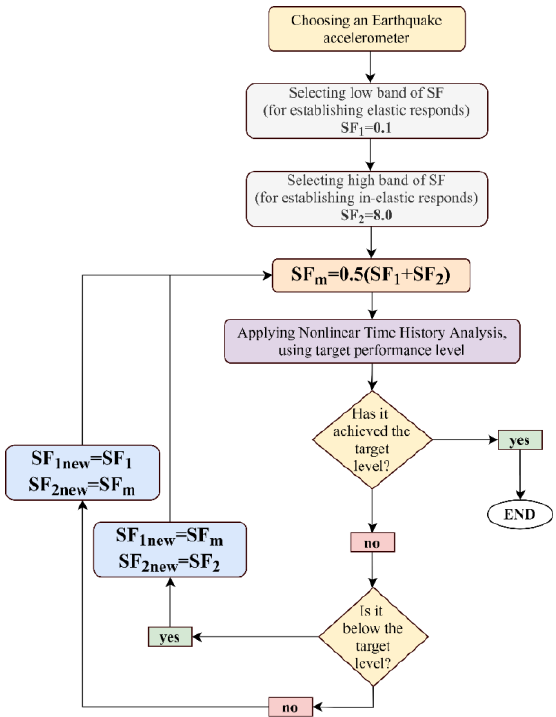
Figure 4. Flowchart of the change in scale